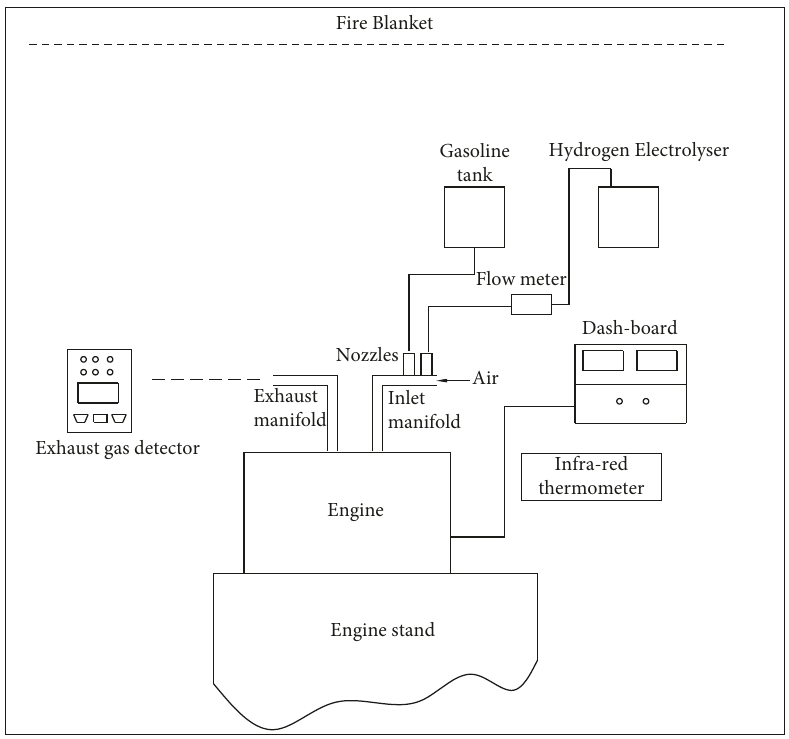
Figure 1: Elements of the experimental